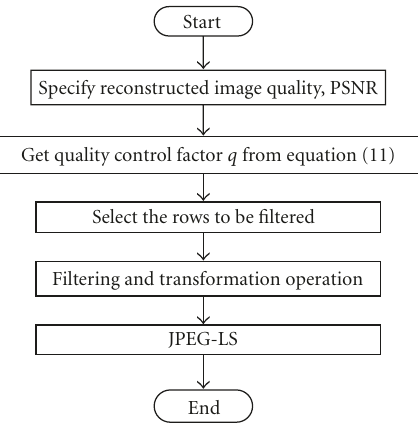
Figure 11: The ROI is in the 2 ∗ 2 dashed